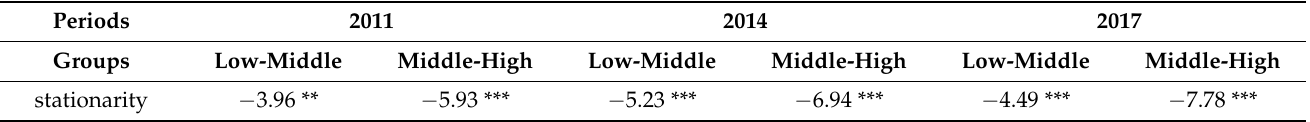
Table 7. Health disparity